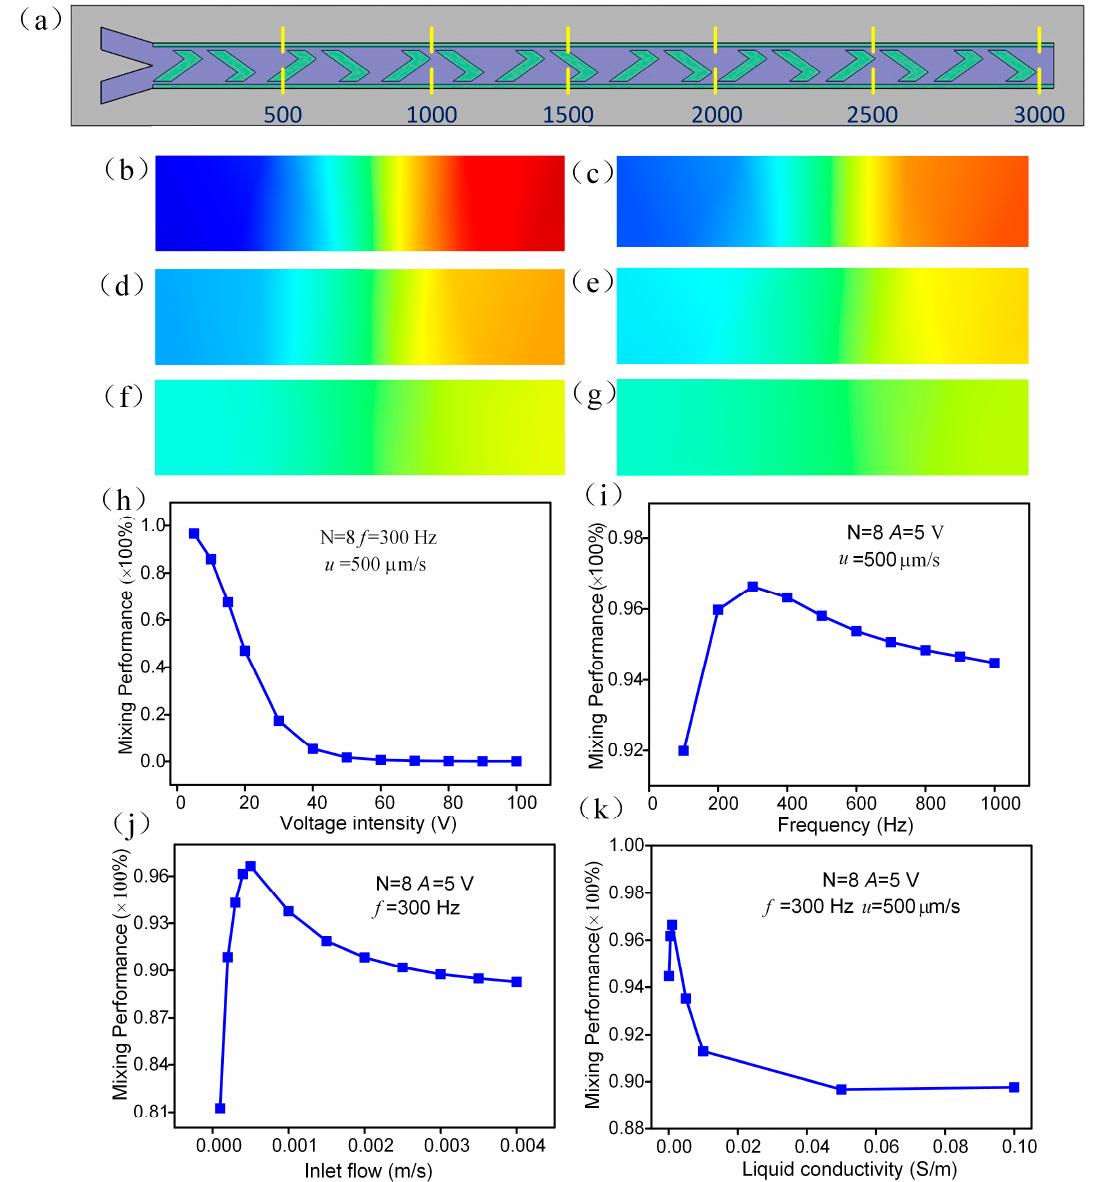
Figure 7. Parametric effect on mixing performance. ( a – g ) the concentration distribution at different cross section of channel at A = 5 V, f = 300 Hz, u = 500 μ m/s. ( b ) The cross section at a range of 500 μ m; effect on mixing performance at f = 300 Hz, u = 500 µ m/s. ( i ) the frequency dependency of mixing performance at A = 5V, u = 500 µ m/s; ( j ) the influence of inlet flow on mixing performance at A = 5 V, f = 300 Hz. ( k ) The relationship of mixing performance and liquid conductivity at A = 5 V, f = 300 Hz, u = 500 µ m/s.